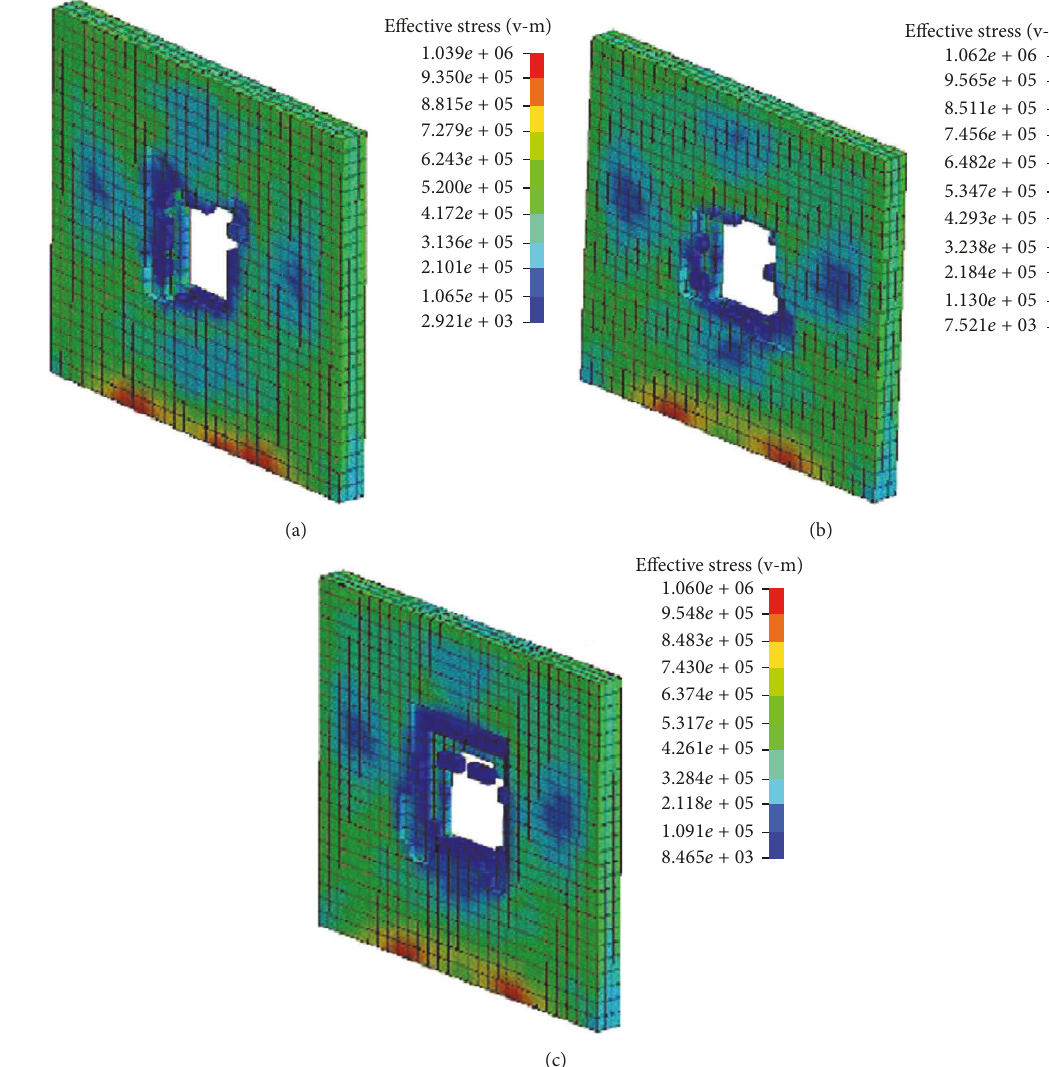
Figure 14: Stress contours of impacted walls at 𝑇 = 300 ms: (a) model 4, (b) model 5, and (c) model 6.